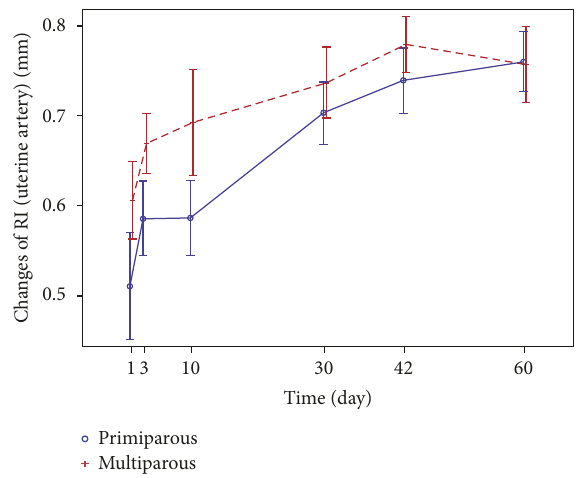
Figure 12: Changes of RI (uterine artery) in primiparous and multiparous women.